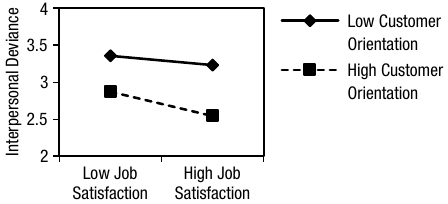
Fig. 2. Moderating role of customer orientation Fig. 3. Moderating role of customer orientation